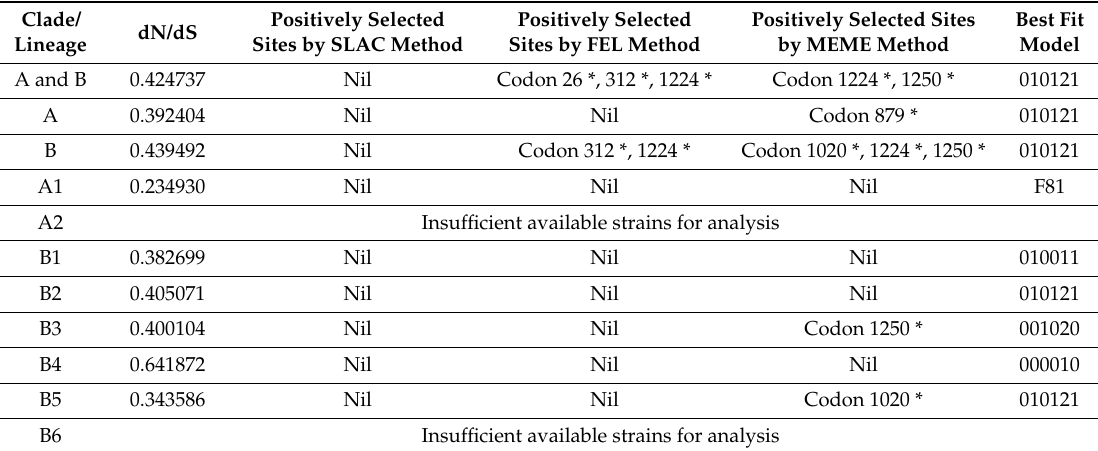
Table 2. Selective pressure analysis on the S genes of 219 MERS-CoV strains.